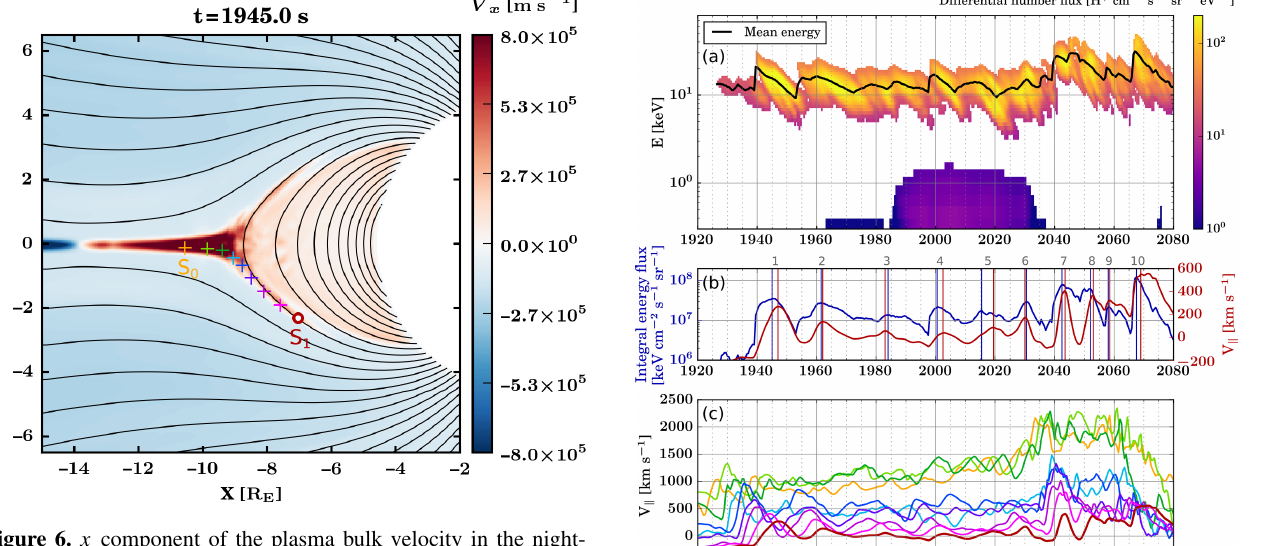
Figure 6. x component of the plasma bulk velocity in the night- side part of the simulation plane at t = 1945 . 0s. The red circle in- dicates the location of virtual spacecraft S 1 , and the eight coloured plus signs show additional virtual spacecraft for which the paral- lel velocity components are shown in Fig. 7. Black lines represent magnetic field lines.